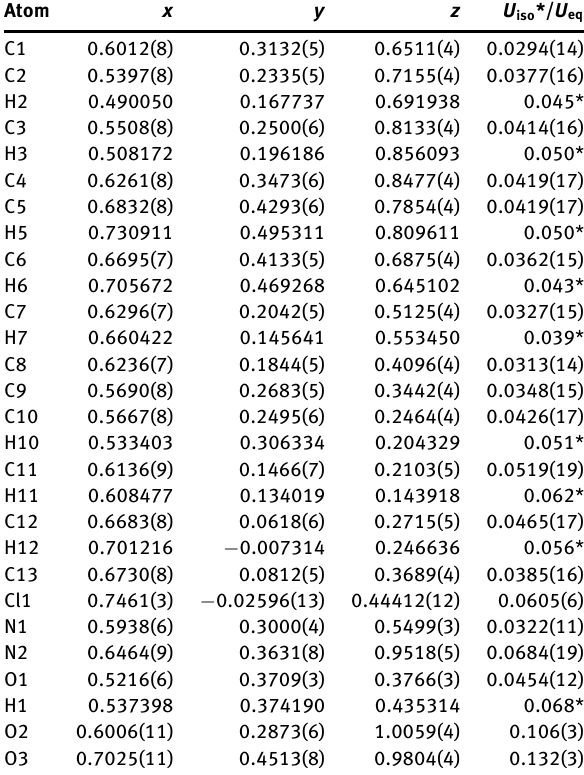
values were refined with U (H) = 1.2 U eq (C) and 1.5 U eq (O). iso The absolute structure was established by refinement of the Flack parameter (0.14(8) from 422 selected quotients) using Parsons’ method